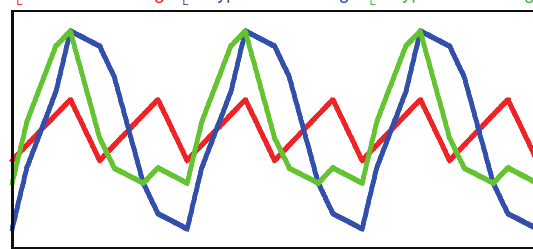
Figure 7. Inductor Currents for interleaving